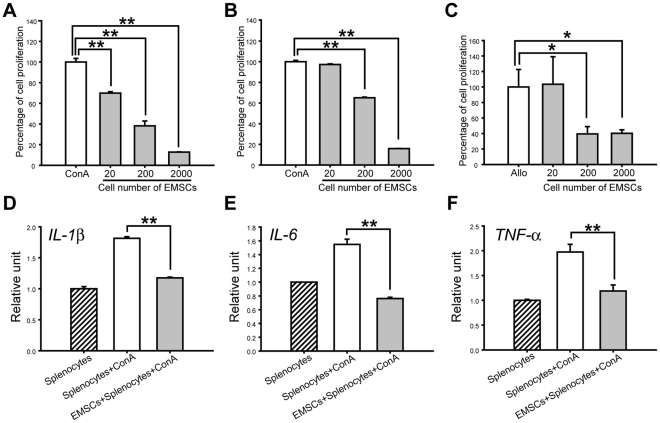
Immunomodulatory properties of EMSCs.(A) Responding splenocytes from C57BL/6 or (B) BALB/c mice were stimulated with Con A in the presence or absence of graded numbers of C57BL/6 EMSCs. The results are shown as percentage of cell proliferation in comparison with control cell proliferation. Splenocytes proliferation was inhibited by culture with EMSCs (at the fifth passage) in a dose dependent manner (n = 3). (C) Responding splenocytes from C57BL/6 mice were cultured with an equal number of mitomycin C-treated BALB/c splenocytes and with or without graded number of C57BL/6 EMSCs (n = 3). Allo indicates allogeneic splenocytes culture. EMSCs inhibited the splenocyte proliferation stimulated by allogeneic cells in a dose dependent manner. (D–F) Analysis of inflammatory cytokine production of splenocyte stimulated by Con A. Inflammatory cytokines expression level of splenocytes were decreased when co-cultured with EMSCs (at the fifth passage) (n = 3). * represents P<0.05, **represents P<0.01. Data are presented as mean ± s.d. and analyzed with Student's t-test.